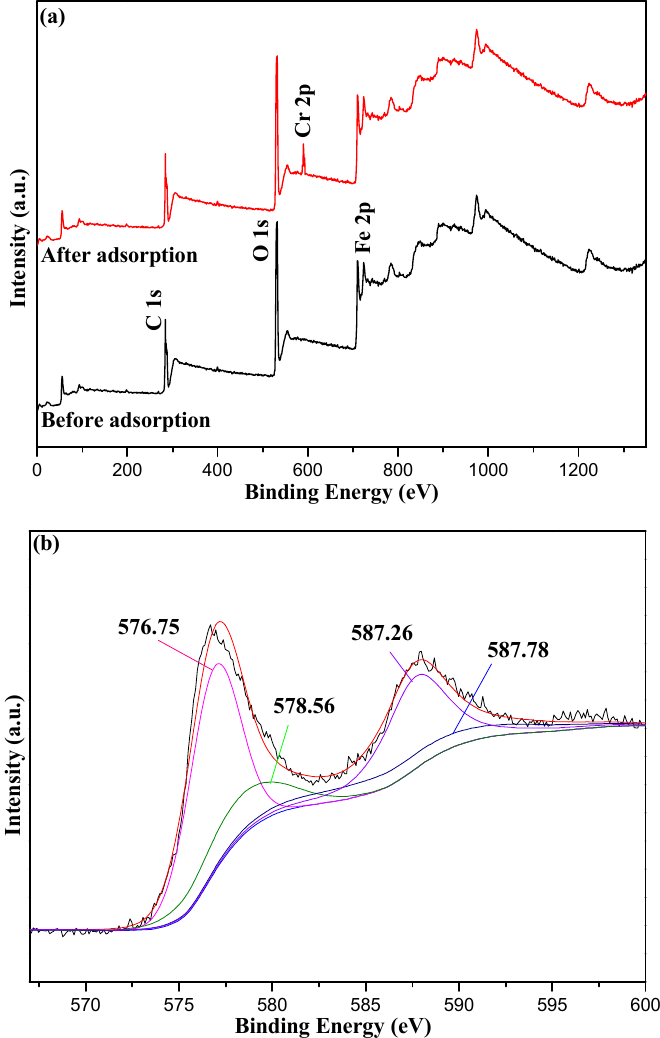
Figure 11. XPS spectra of the 10%-Fe 3 O 4 @ SC adsorbent. ( a ) Full-scan; ( b ) High-resolution of Cr 2p after adsorption.